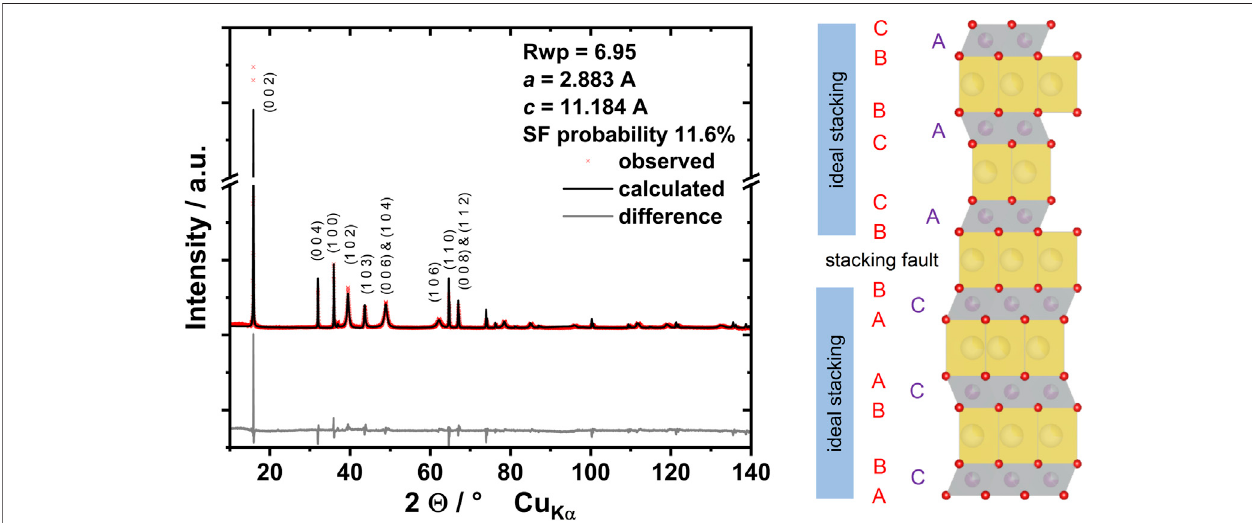
FIGURE 6 | Re fi ned powder XRD pattern of a phase pure P2 material with stacking faults (left) and schematic representation of the stacking fault sequence (right).